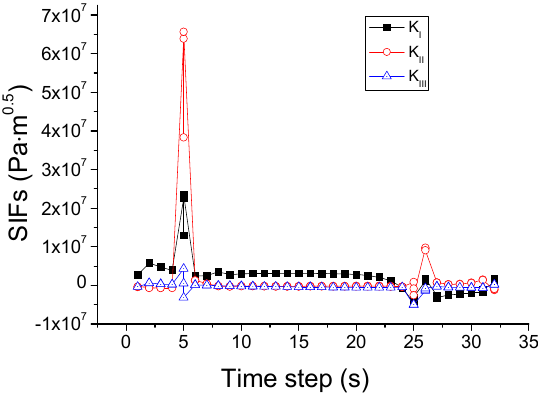
Figure 17. Variation of SIFs associated with the maximum circumferential stress criterion.